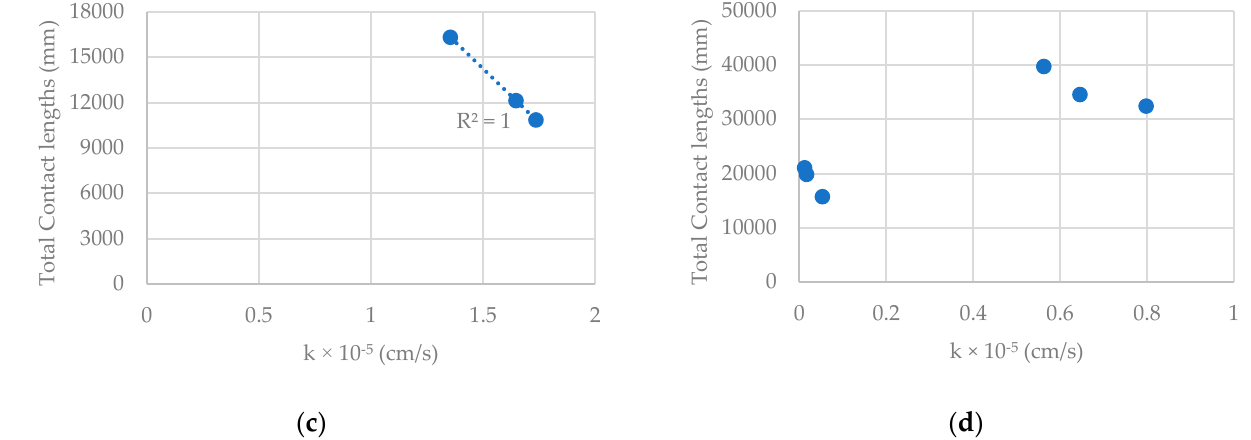
Figure 11. Correlation of total aggregate contact lengths calculated for the skeleton with permeability, ( a ) AC60/70 with dense gradation, ( b ) AC60/70+CB with dense gradation, ( c ) AC60/70+SBS with porous gradation, and ( d ) the combination of dense gradation set ( a , b ).